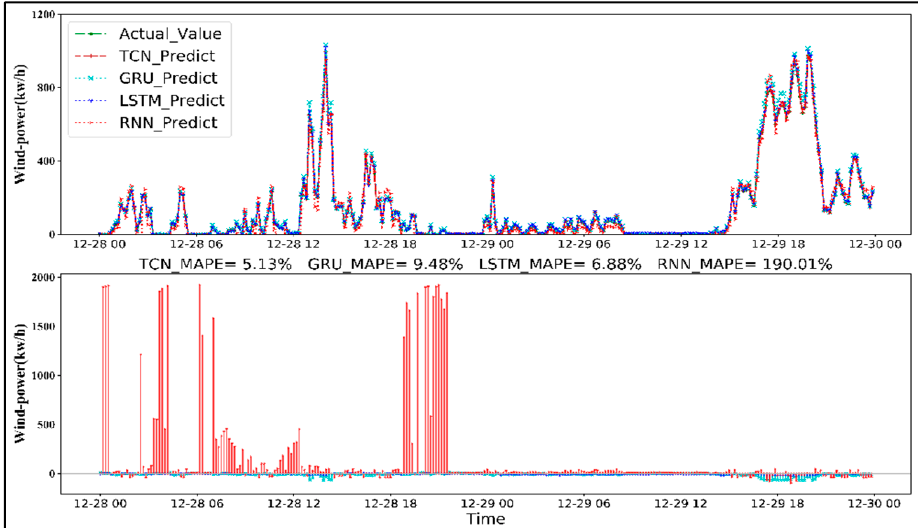
Figure 13. 48-h wind power forecasting (Experiment II).